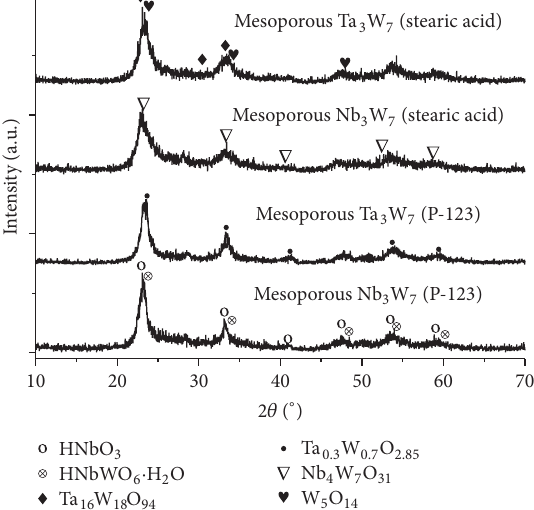
Figure 2: Wide-angle diffraction patterns of mesoporous Nb 3 W 7 oxide (P-123), mesoporous Ta 3 W 7 oxide (P-123), mesoporous Nb 3 W 7 oxide (stearic acid), and mesoporous Ta 3 W 7 oxide (stearic